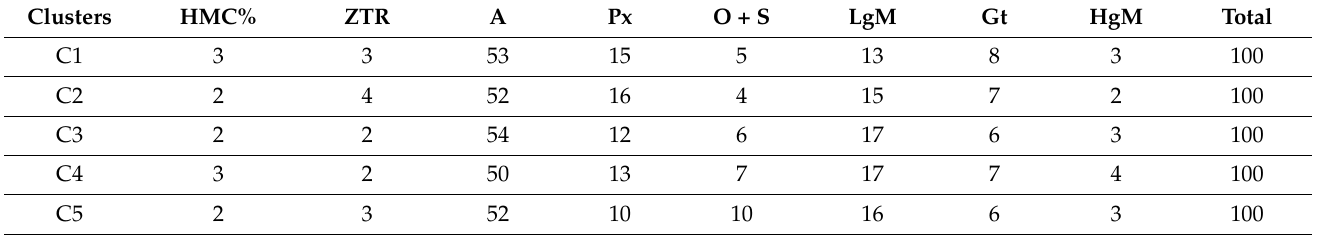
Figure 5. The mineralogical composition of Indus River deposits in samples of different clusters (C1, C2, C3, C4 and C5). Table 2. The heavy mineral percentage of samples (HMC = weight percentage of heavy minerals, ZTR = ultrastable minerals (zircon, tourmaline, rutile), A = amphibole, Px = pyroxene, O + S = olivine + chromespirel, LgM = low-grade minerals (mostly epidote group minerals), Gt = garnet, HgM = high-grade minerals (stauolite, andalusite, kynite, silliminite and other minerals (mainly sphene).